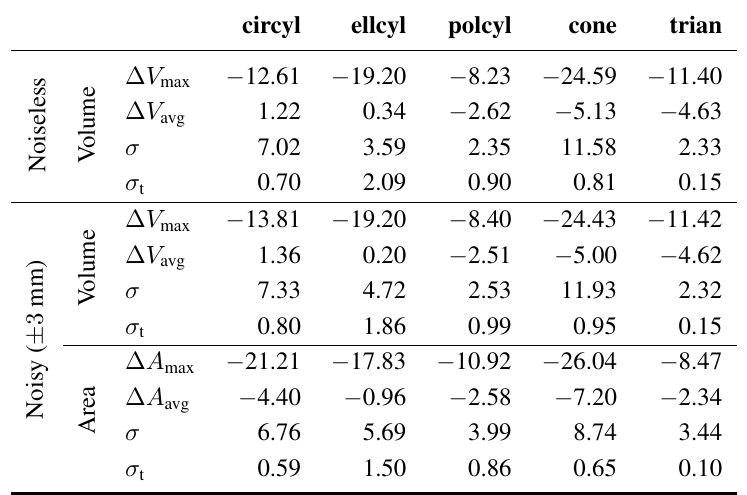
Table 1. Reconstruction results of generated stems. Maximum and average difference in percentages for the volume and surface area. Negative values stand for underestimation. The standard deviation of the average error ( σ ) and average of the standard deviations for the individual stems ( σ ) are also listed in percentage points t